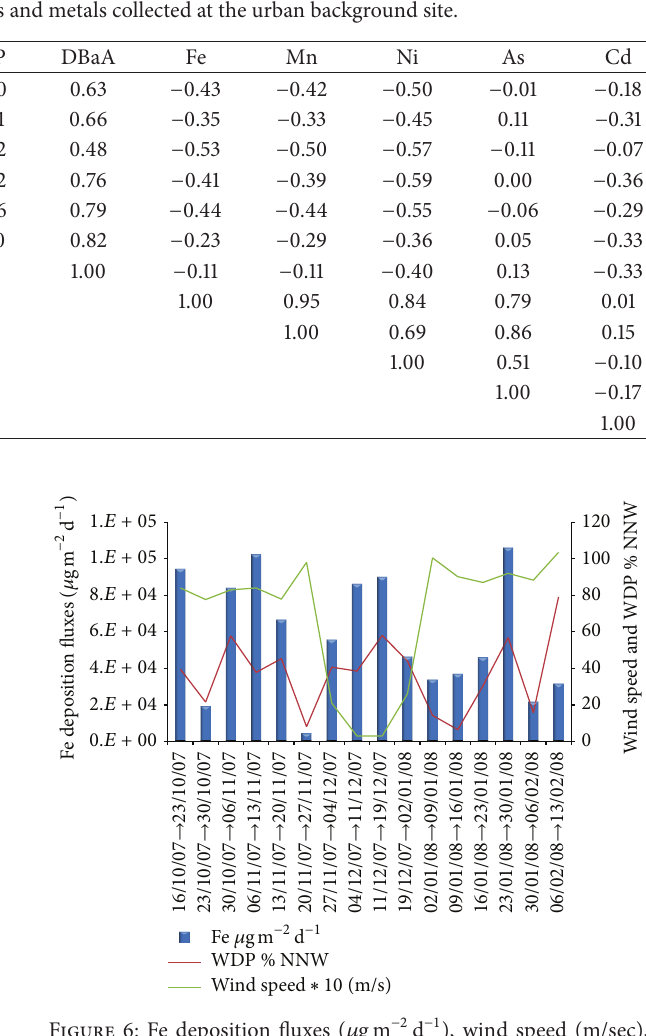
Figure 5: Percentage contributions of each PAH to the total deposition fluxes at the urban background site.